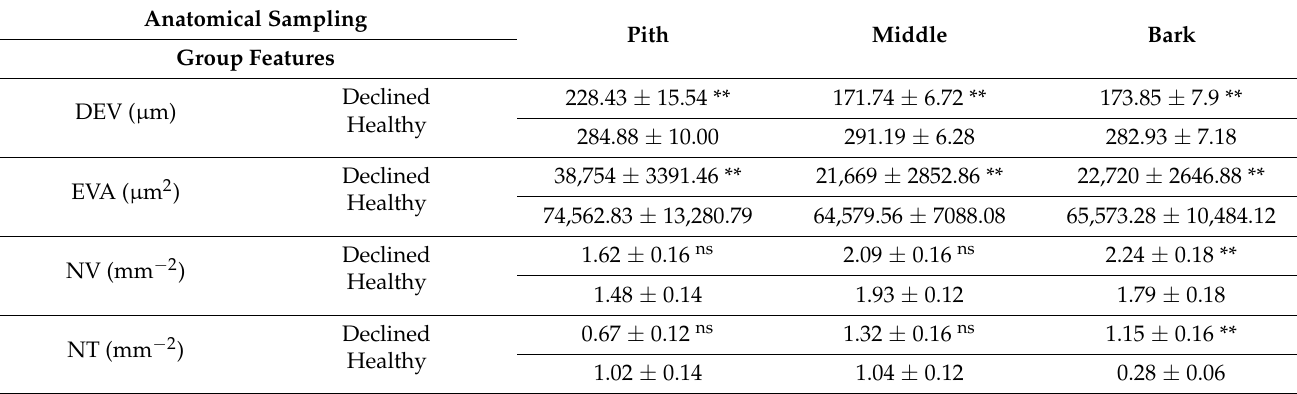
Table 5. Differences in wood characteristics (means ± SE) between healthy and declined trees based on Student’s t -test. Anatomical